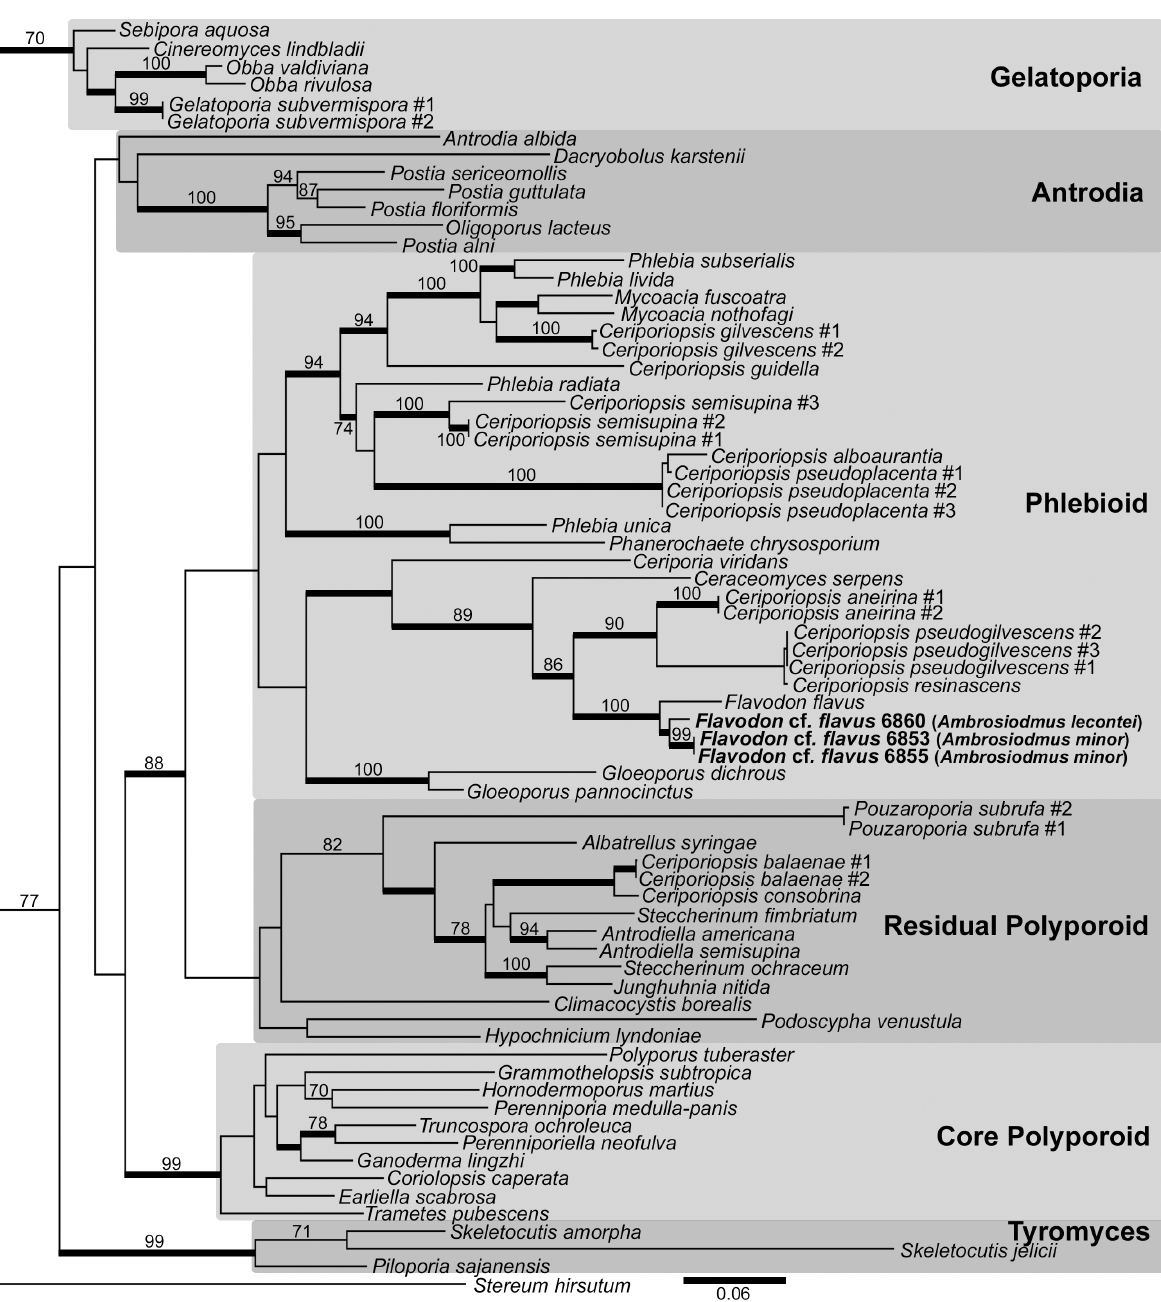
Fig 3. Best ML tree from GARLI analysis of combined nuclear ITS and 28S rDNA datasets. Flavodon cf. flavus isolates, with host beetle in parentheses, within phlebioid clade of Polyporales. Values at nodes indicate (cid:2) 70% ML bootstrap support, and thickened branches indicate (cid:2) 95% Bayesian posterior probability support